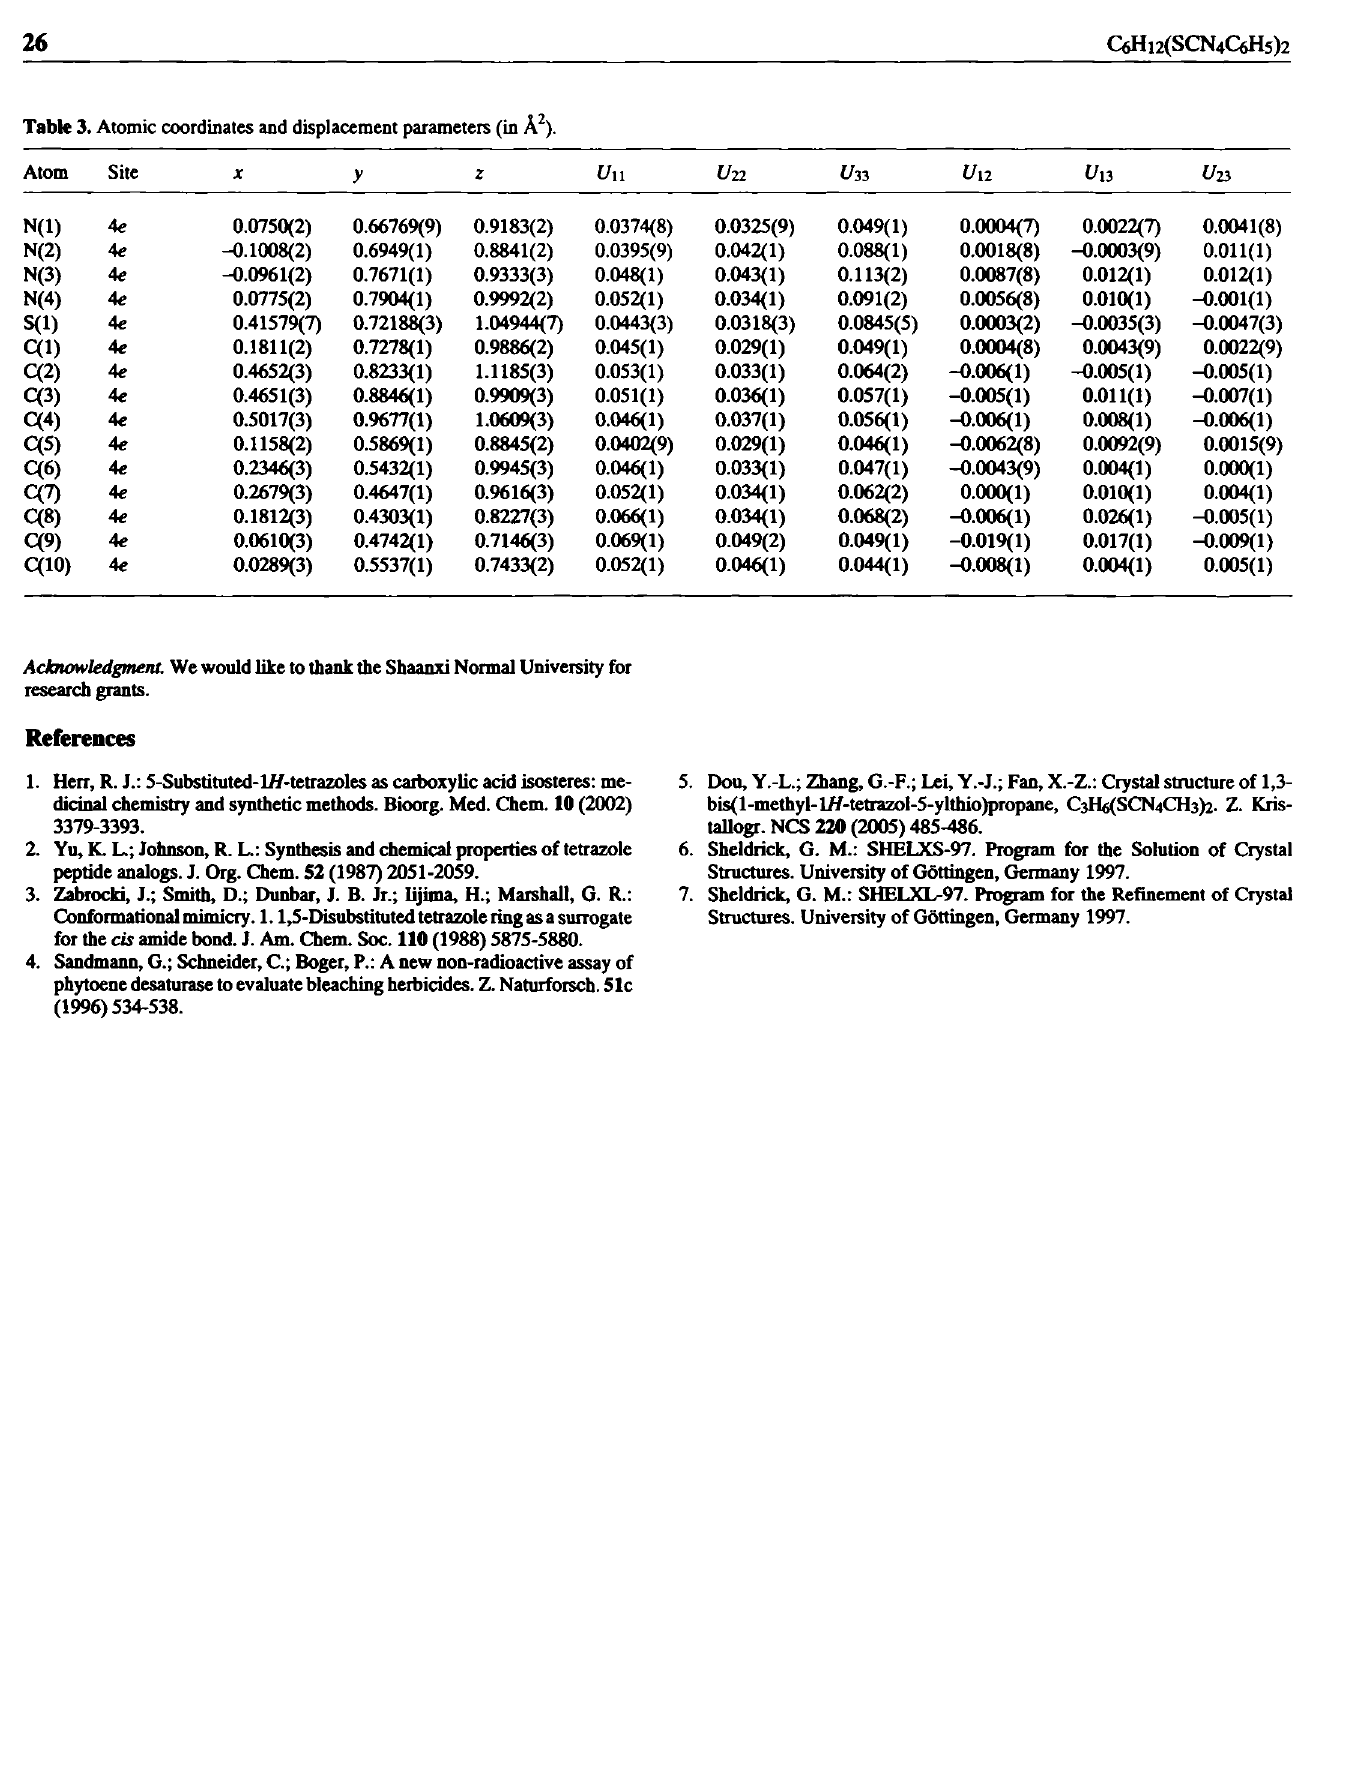
Table 3. Atomic coordinates and displacement parameters (in Ä 2